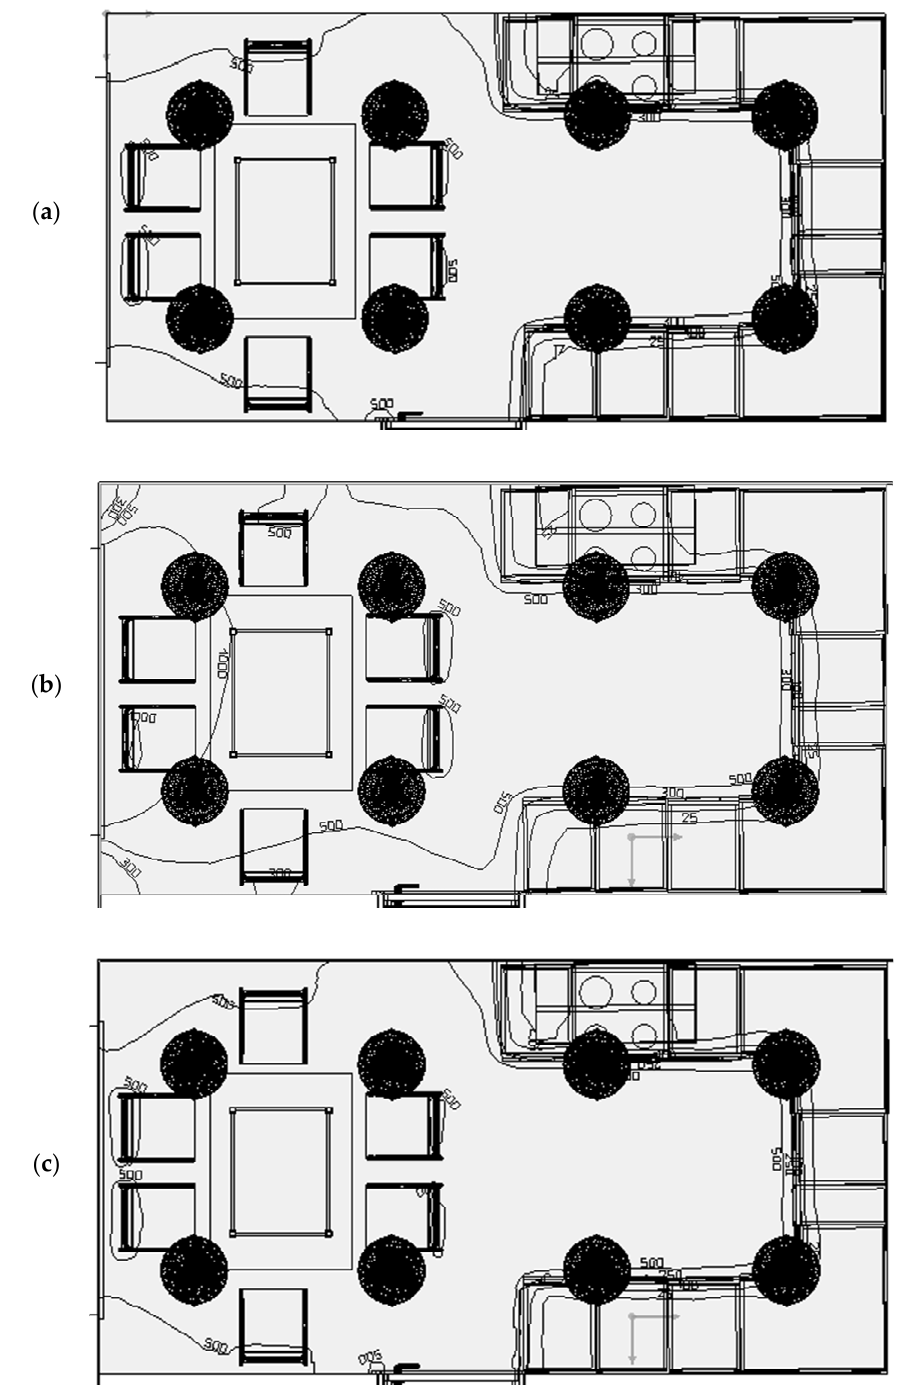
Figure A3. The even pattern of the simulation result from combining the artificial light of the smart adaptive lighting system for 500 lux illumination and the sunlight in DIALuxEvo 8.1 ( a ) at sub-scenario A, 6:00 a.m., 1 May 2019; ( b ) at sub-scenario B, 9:00 a.m., 5 June 2019; and ( c ) at sub-scenario C, 4:00 p.m., 10 November 2019.